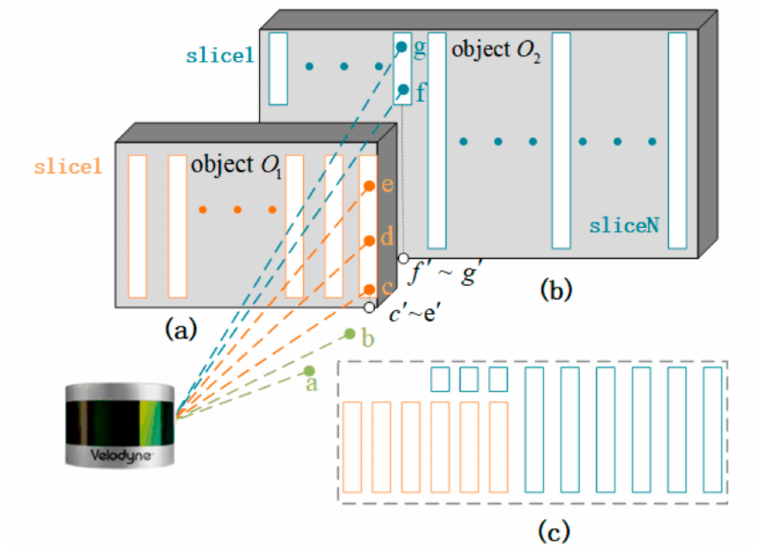
Figure 2. The schematic diagram of a LiDAR slice. ( a ) Points and slices within object O 1 . ( b ) Points and slices within object O 2 . ( c ) Slices and objects within a vertical plane.